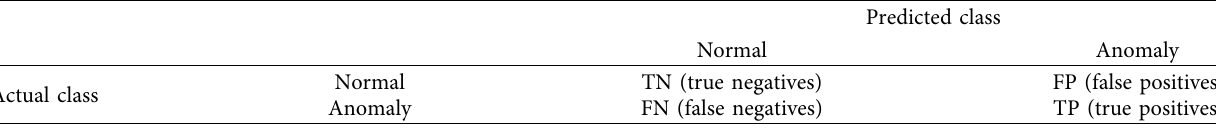
Table 3: Confusion matrix.